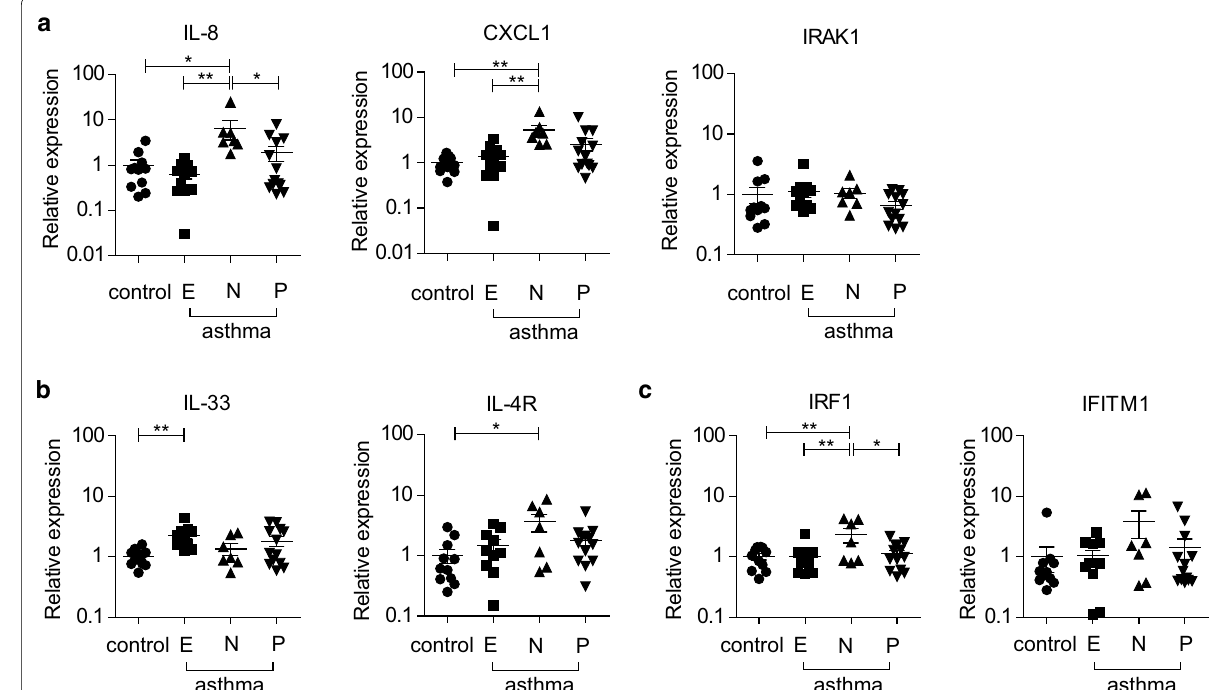
Fig. 2 The expression of miR-146a-influenced chemokines is increased in brush biopsy airway epithelial cells from asthma patients with neutrophilic asthma phenotype. Relative mRNA expression of indicated miR-146a-influenced genes ( a ), genes associated with Th2 type responses ( b ) and interferon dependent genes ( c ) in bronchial brushing specimens from patients with asthma was measured by RT-qPCR and compared to the expression levels in the samples from control individuals. a–c Patients were categorized into inflammatory phenotypes based on BALF cell percentages: eosinophilic (E), > 2% of eosinophils and < 3% of neutrophils in BALF; neutrophilic (N), < 2% eosinophils and > 3% neutrophils in BALF; paucigranulocytic (P), < 2% of eosinophils and < 3% neutrophils in BALF). Data represent mean SEM. One-way ANOVA, *P < 0.05, **P < ±